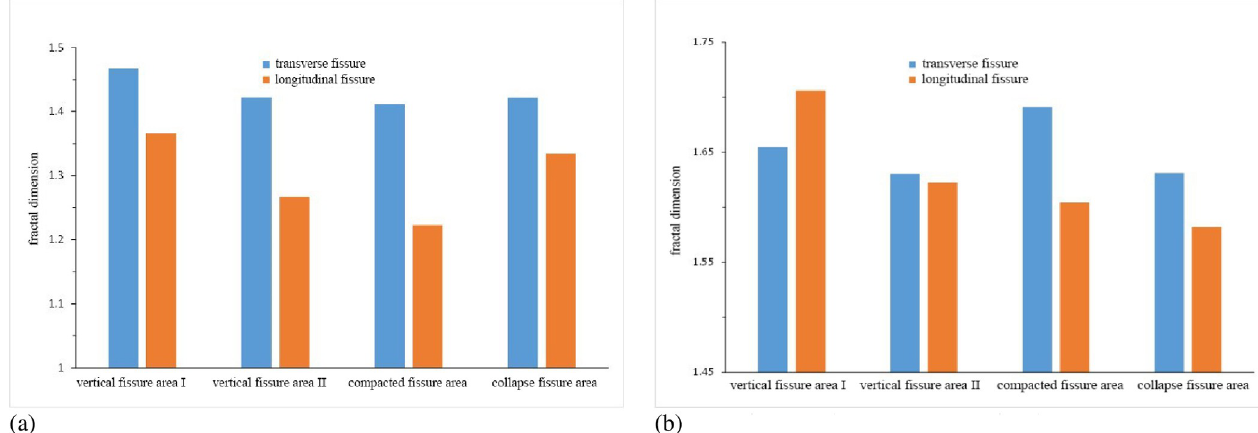
Fig 10. Fractal dimension of transverse and longitudinal fissures in each region. (a) Statistical results of similar simulation; (b) Statistical results of numerical simulation.